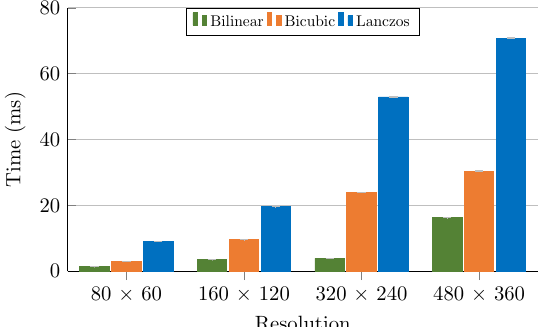
Figure 19. Time for downscaling the RGB to different resolutions with different modes. The original resolution of the image is 640 480. The gray lines indicate the confidence ×